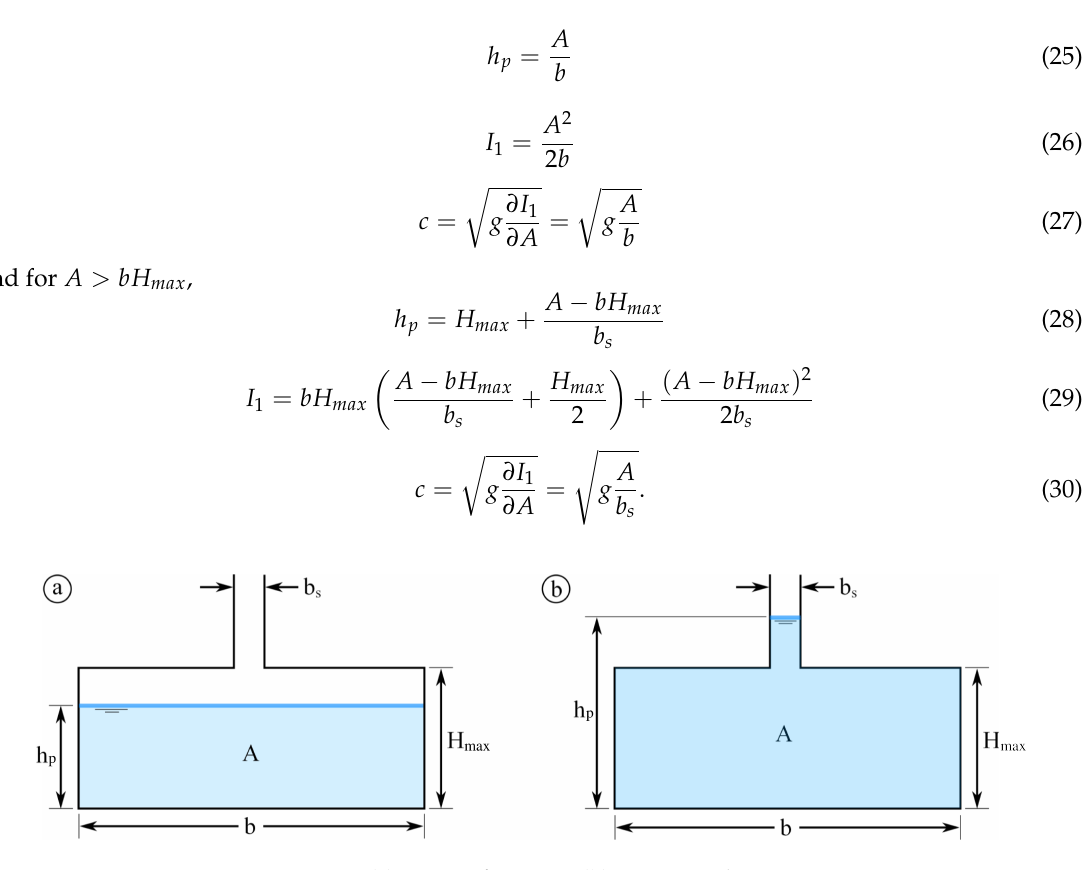
Figure 2. ( a ) Free surface pipe; ( b ) pressurized